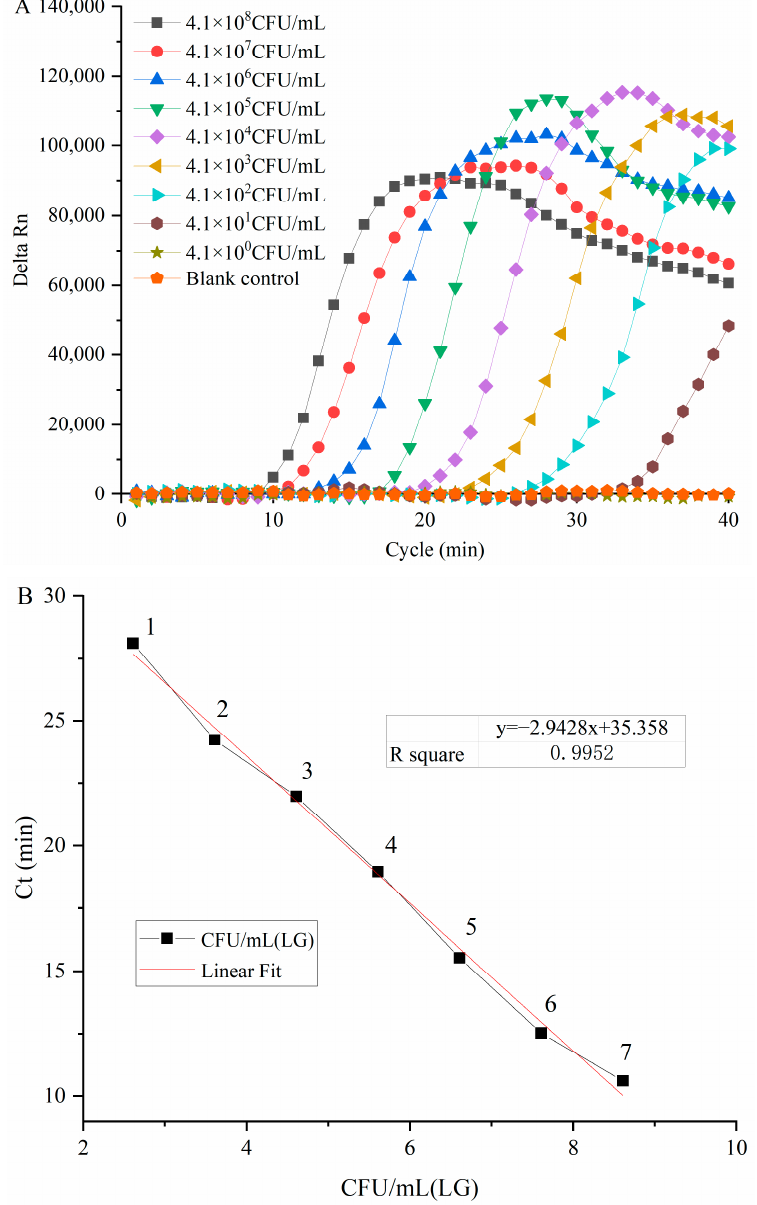
Figure 3. The quantitative detection limit and linear relationship of PMA-QLAMP for 10 series of dilution concentrations of viable C. sakazakii . ( A ) A 10-point C. sakazakii suspension serial dilution led to concentrations ranging from 4.1 × 10 8 to 4.1 × 10 2 CFU/mL, with average Ct values of 10.61, 12.52, 15.53, 18.96, 21.97, 24.24, 28.12, and 34.28 min, respectively. The interval (about 3 min) was the same and uniform between every two adjacent Ct values. For C. sakazakii suspension concentra- tions of 4.1 × 10 2 and 4.1 ×10 1 CFU/mL, the Ct values were 28.12 and 34.28 min, respectively. The interval (6.16 min) became significantly larger between 28.12 and 34.28 min. ( B ) Draw a standard curve. From the standard curve, there was a linear relationship (y = − 2.9428x + 35.358, R 2 = 0.9952) between Ct values (10.61–28.12 min) and log concentrations (no. 7–1: 8.61, 7.61, 6.61, 5.61, 4.61, 3.61, and 2.61, respectively) of viable C. sakazakii . PMA-QLAMP detection limit for viable C. sakazakii ATCC29544 added in the 10% PIF solution with concentrations (plate count) ranging from 4.3 × 10 8 to 4.3 × 10 0 CFU/mL was determined. Average Ct values of the dilutions were 9.80, 12.08, 15.77, 18.15, 22.36, 24.22, 27.69, and 34.00 min. The Ct values (13.08, 16.77, 19.15, 22.36, 24.22, and 27.69 min) were determined using the standard curve; all remained within the accurate quantitative range (10.61–28.12 min). The corresponding concentration of C. sakazakii at the maximum quan- titative Ct value (27.69 min) was 4.3 × 10 2 CFU/mL. PMA-QLAMP detection limit for via- ble C. sakazakii in the 10% PIF solution was 4.3 × 10 2 CFU/mL. 3.5. Quantitative Detection Results of C. sakazakii VBNC State A series of diluted viable C. sakazakii concentrations in 10% PIF solution were de- tected using QLAMP. Before pasteurization, the measured values of the serial concentra- tions of viable C. sakazakii were expressed by logarithm viable C. sakazakii concentrations, and the mean ± standard deviation (Table 3), which were 7.64 ± 0.02, 6.67 ± 0.04, 5.72 ± 0.01, 4.8 ± 0.03, 3.87 ± 0.02, 2.8 ± 0.02, and 1.76 ± 0.04, respectively. Following pasteurization at 65 °C for 30 min, the series of diluted viable C. sakazakii concentrations in 10% PIF solu- tion were measured by plate counting. At 10 4 CFU/mL, the logarithm of bacterial concen- tration was 0, the corresponding logarithm of bacterial number detected by PMA-QLAMP was 2.93, and the logarithm of bacterial number detected by PMA-QLAMP at 10 2 CFU/mL was 0. At 10 6 CFU/mL, the highest proportion of VBNC state of C. sakazakii was 15.32%. The results showed that pasteurization of 10 6 CFU/mL of viable C. sakazakii resulted in the